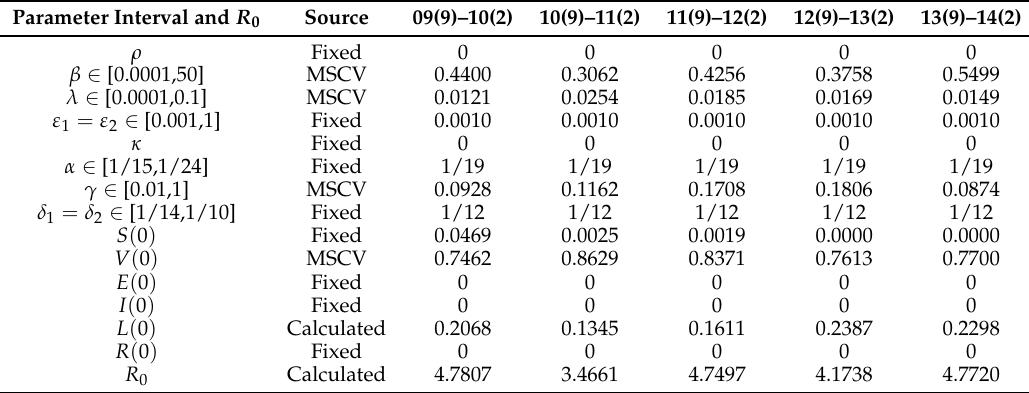
Table A2. Estimation of parameters and the basic reproduction number of the latter half of the year (LHY, e.g., 09(9)–10(2) stands for September of 2009 to February of 2010, and MSCV stands for the minimum sum of chi-square value.) from 2009 to 2014.